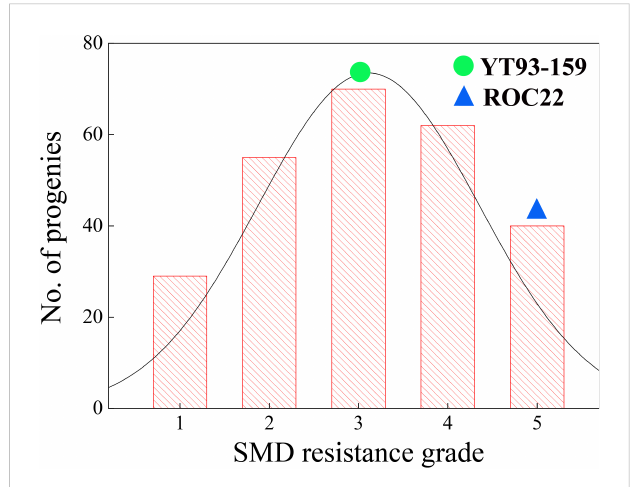
FIGURE 3 Distribution of fi ve SMD resistance grades (Table 2) within a sugarcane mapping population YT93-159 belongs to Grade 3 and ROC22 belongs to Grade